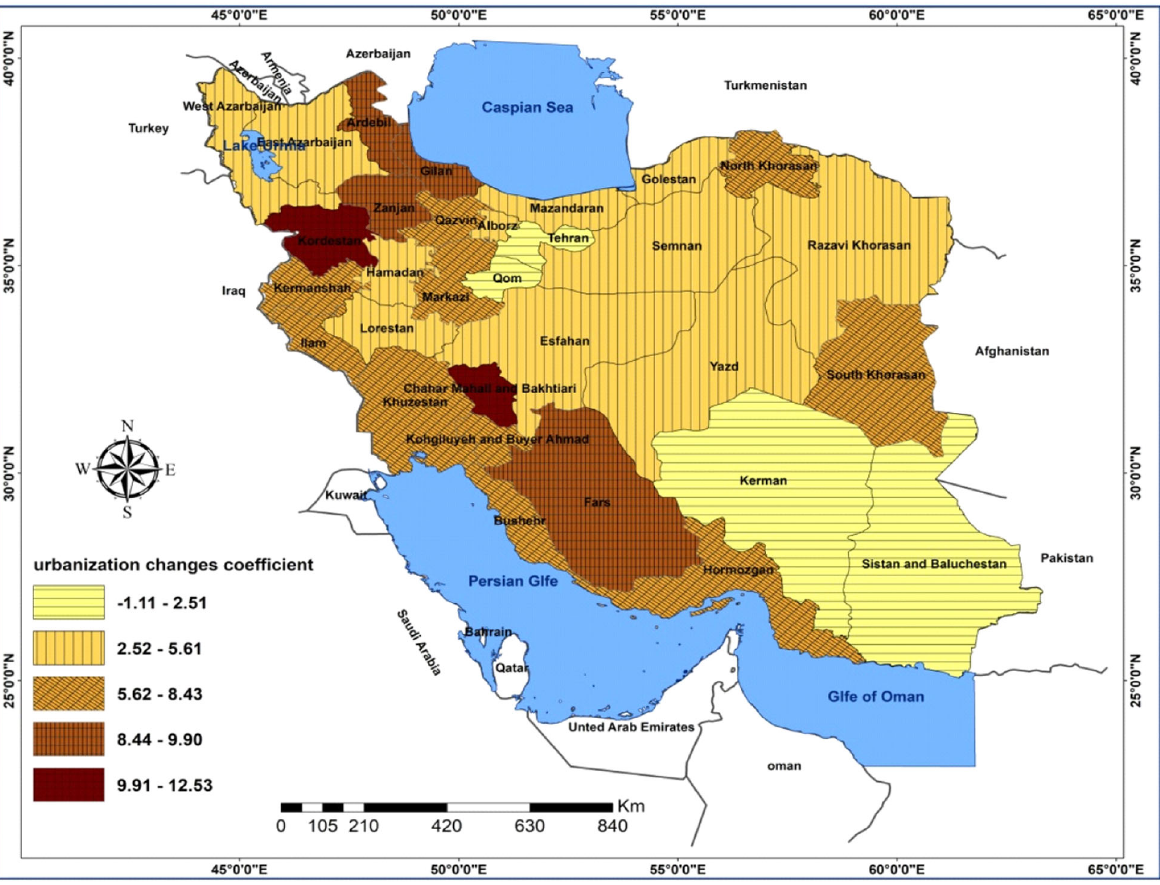
Fig. 7 Rate of urbanization changes in Iran ’ s provinces (2006 – 2016). As depicted in fi gure, urbanization has taken an upturn so that in some provinces such as Fars, Gilan, Ardabil, Zanjan, Kurdistan and Chaharmahal and Bakhtiari, it has increased from 8.44 to 12.53. Figure shows the highest CV in western Iran. The western regions have more natural and human resources than the eastern areas. In the eastern part of Iran, desert and low water areas have had a bearing on migration. (Source: Research fi